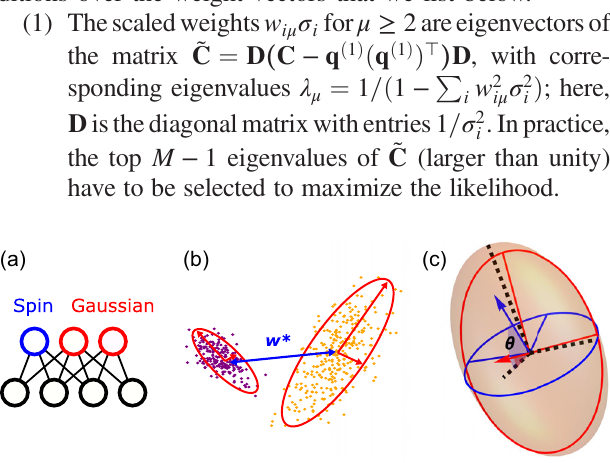
FIG. 13. Gaussian-spin RBM. (a) The Gaussian-spin RBM has one spinlike hidden unit h (cid:4) ¼ h 1 ¼ (cid:2) 1 , whereas all other hidden units are Gaussian. (b) The spin hidden unit (blue) separates the two labeled classes. Gaussian hidden units (red) model intraclass variability. (c) Illustration of Poincar´e